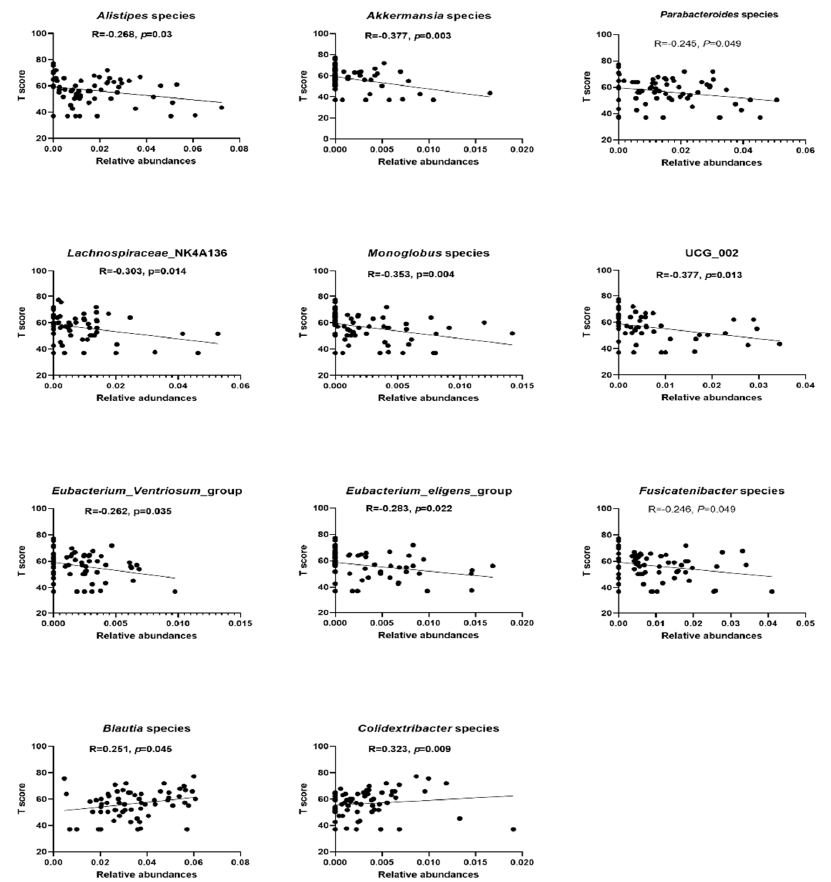
Figure 5. Principal component analysis of gut microbiota composition in the FAPDs and the control groups. Green circles represent the control, while red triangles denote the FAPDs group (PERMANOVA = 2.38; p = 0.002).